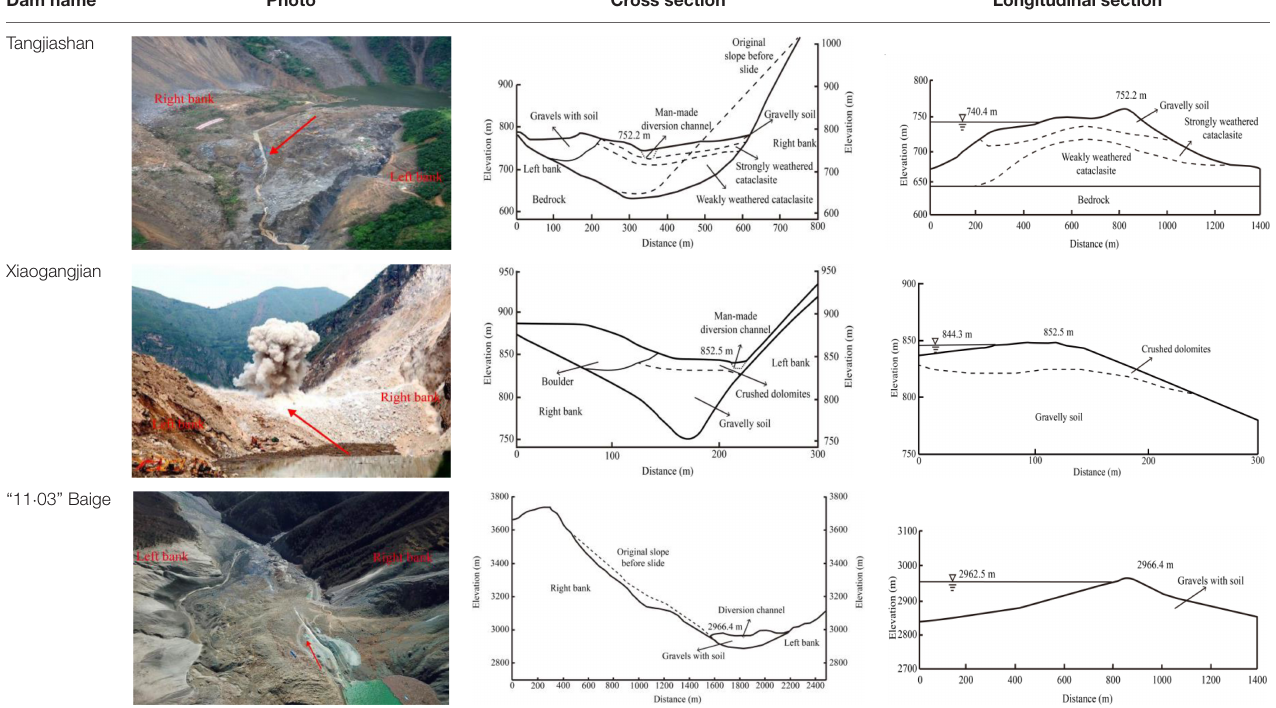
TABLE 1 | Photos and profiles of three landslide dams, red arrows indicate the position and direction of the longitudinal section. Dam name Photo Cross section Longitudinal